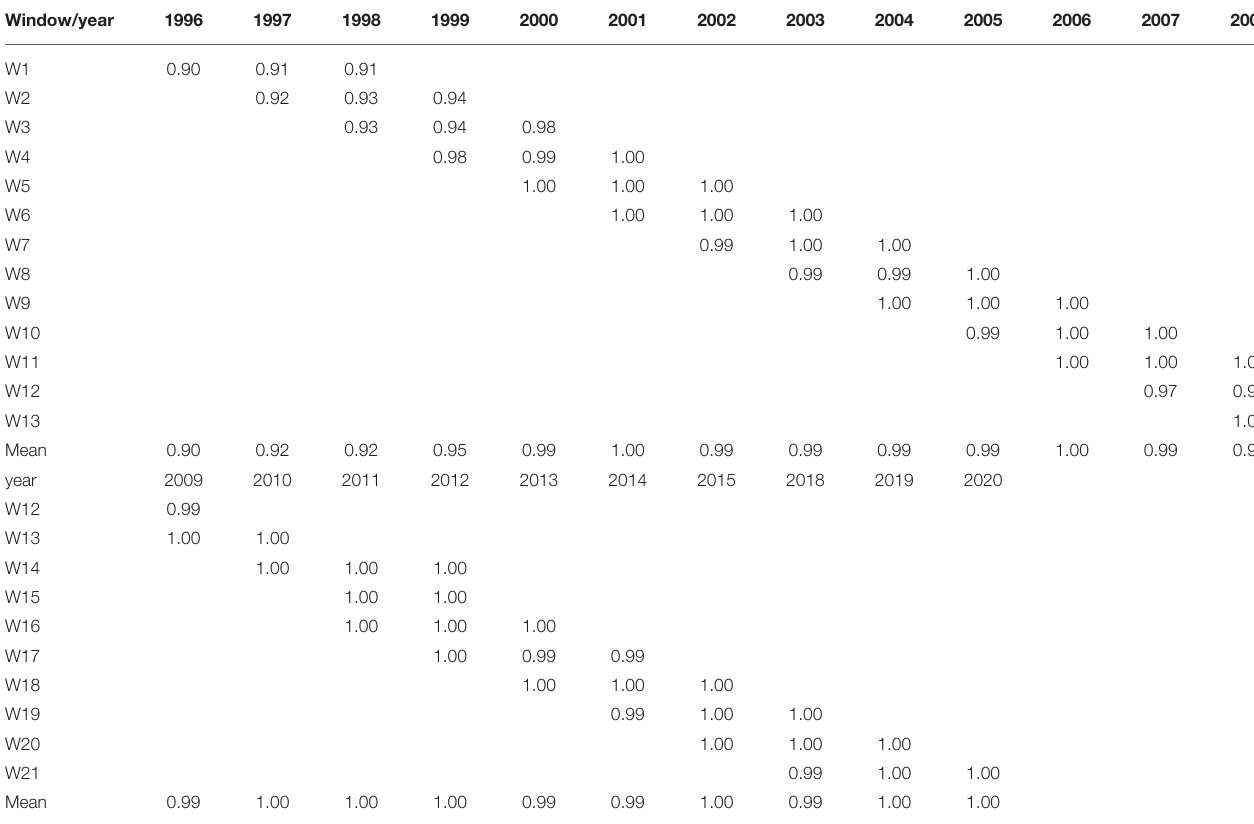
TABLE 4 | DEA window